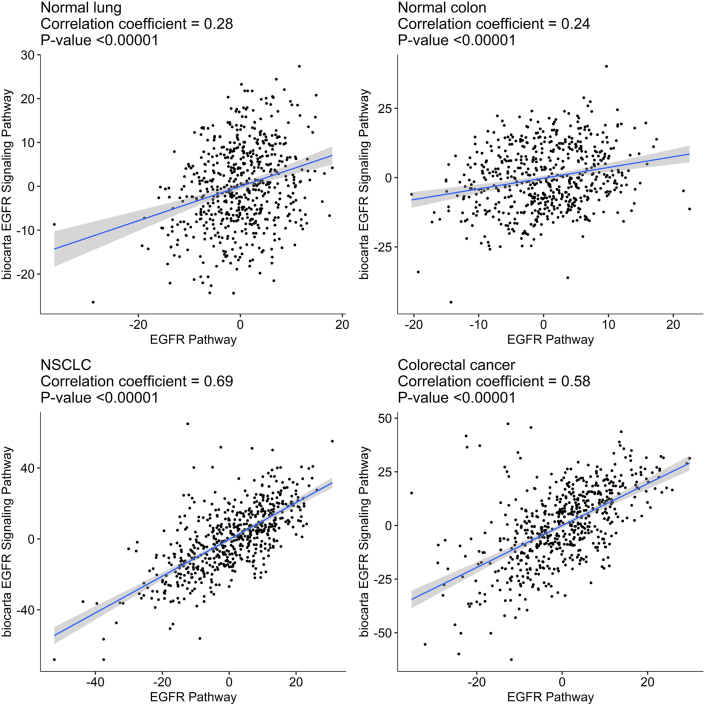
Correlation of pathway activation level (PAL) of the EGFR pathway from Qiagen Pathway Central annotation with PAL of the EGFR pathway from Biocarta pathway annotation. Panels represent correlations for the cancerous (TCGA database) and normal (GTEx database) lung and colon tissues.